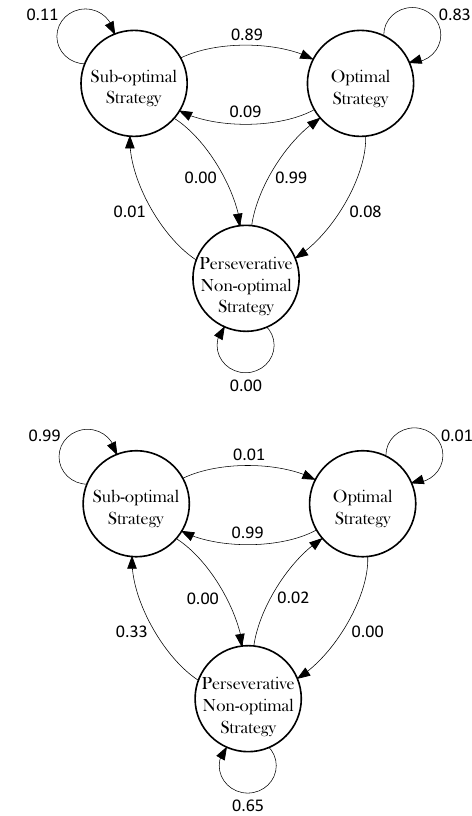
Figure 3. Transition probability matrices ( left ) and relative graphical model representations ( right ) for the control group ( top ) and the SDI group ( bottom